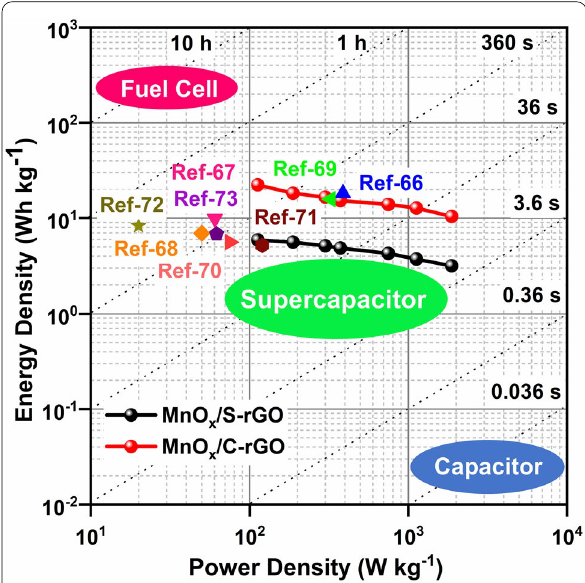
Fig. 7 Ragone plots of the symmetric devices with MnO x /S-rGO and MnO x /C-rGO